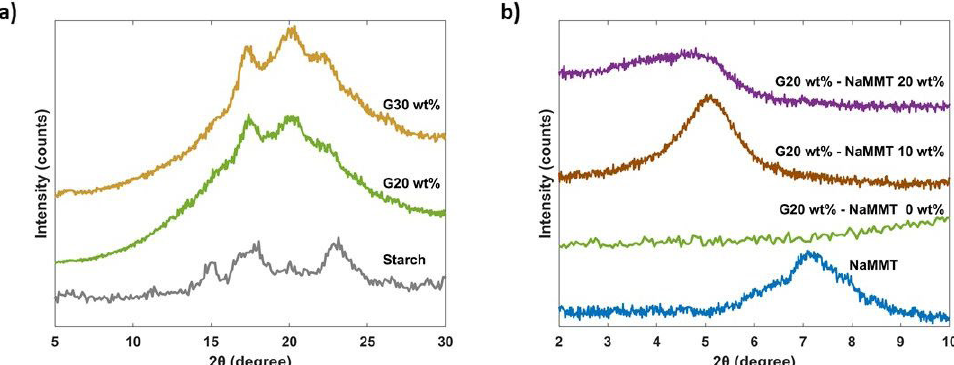
Figure 5. XRD diffraction patterns of (a) maize starch and conventional composites G20 and G30 with 20 and 30 wt% glycerol concentrations, respectively, and (b) NaMMT (Ma) and G20-Ma0, G20-Ma10, G20-Ma20, nanocomposites containing 0, 10 and 20 wt% NaMMT Ma clay, respectively, with 20 wt% glycerol concentration.